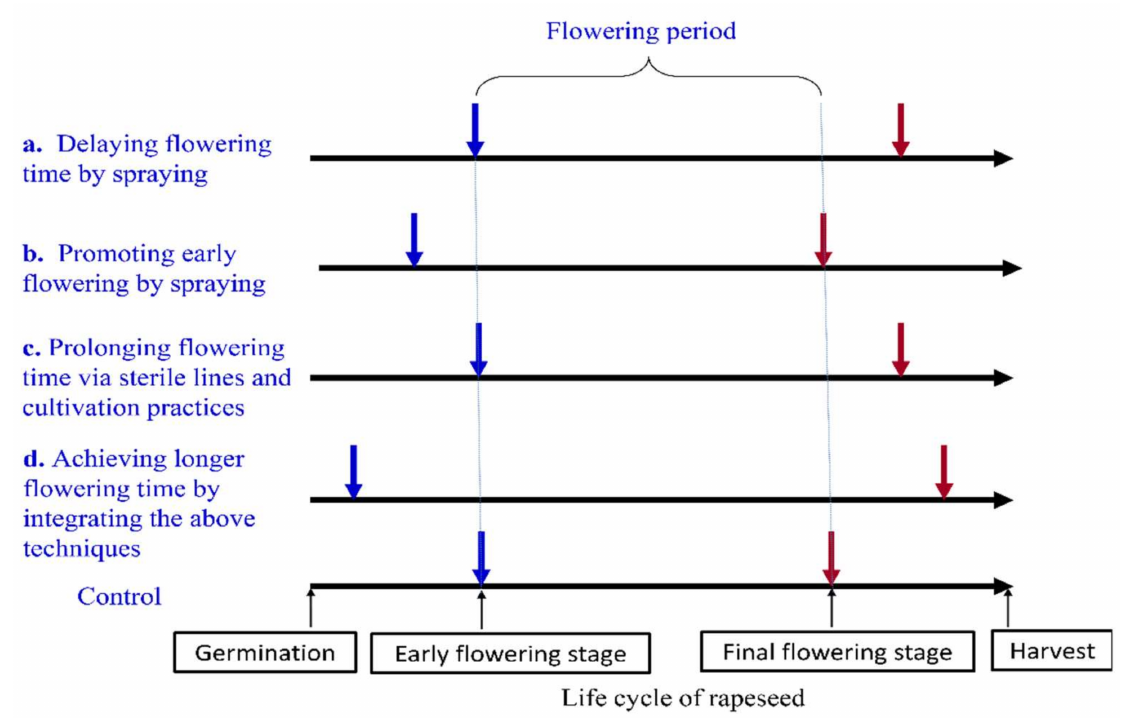
Figure 4. Strategies for prolonging the flowering period. To prolong the flowering period, there are four major methods: ( a ) spraying reagents which can delay flowering; ( b ) spaying reagents which can promote early flowering; ( c ) prolonging the flowering period by using sterile lines and cultivation practices; and ( d ) prolonging the flowering period by integrating techniques ( a – c ). The blue and red arrows represent the “point” of the early flowering stage and “point” of final flowering stage, respectively. “Control”, at the bottom of the diagram, exhibits the planting cycle of rapeseed under ordinary planting and management